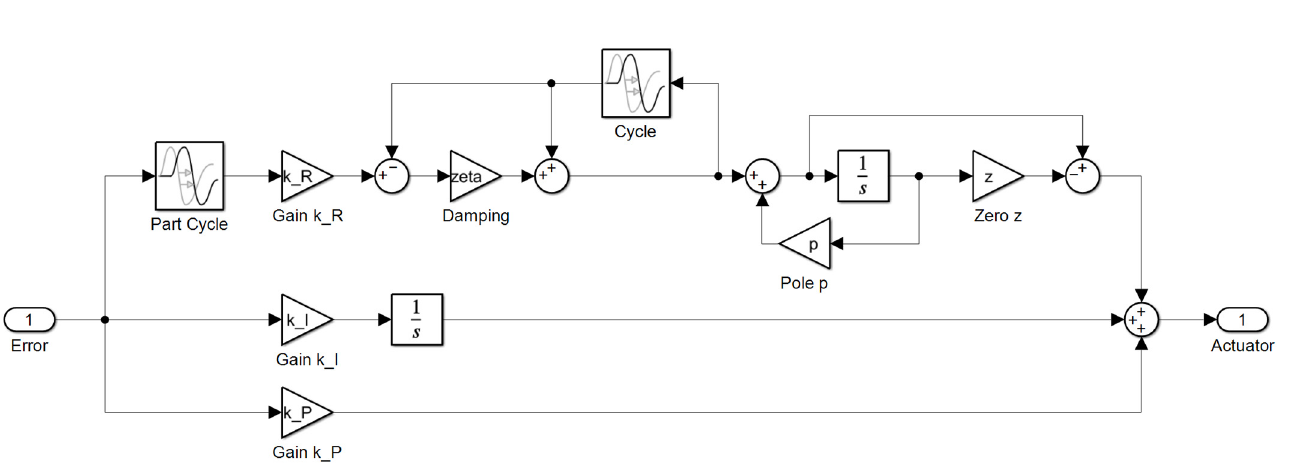
Figure 5. The Iterative Learning Control structure.